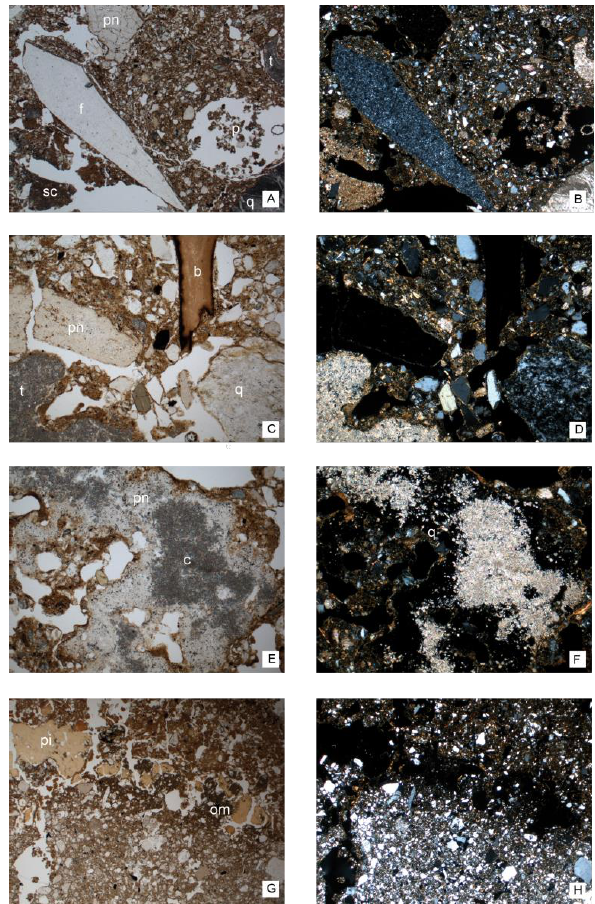
Figure 10. Micrographs from Arbreda Cave. (A) Flint (f), travertine (t) and quartzite (q) fragments, phosphate nodule (pn), secondary calcite (sc) and large biopore in thin section CA-MM7 from sediment unit B1.1 (plain polarized light (PPL), frame width is ∼ 5mm). (B) Same as (A) but crossed polarizers (XPL). (C) Partially burned bone (b), quartzite (q) and travertine (t) fragments, phosphate nodule in thin section CA-MM7 (PPL; frame width ∼ 1 . 25mm). (D) same as (C) , but XPL. (E) phosphate nodule (pn) with intergrowth of micritic calcite (PPL; frame width ∼ 1 . 25mm). (F) Same as (E) , but XPL. (G) phosphate infillings (pi) and organic matter (om) at the boundary between levels I (upper part) and J (lower part) in thin section CA-MM1 (PPL; frame width ∼ 5mm). The light orange P infillings on the right-hand side are probably stained by organic matter. (H) same as (G) , but XPL.